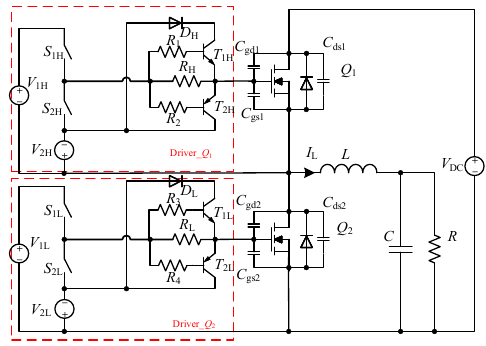
Figure 5. Proposed driver for suppressing the crosstalk issue.